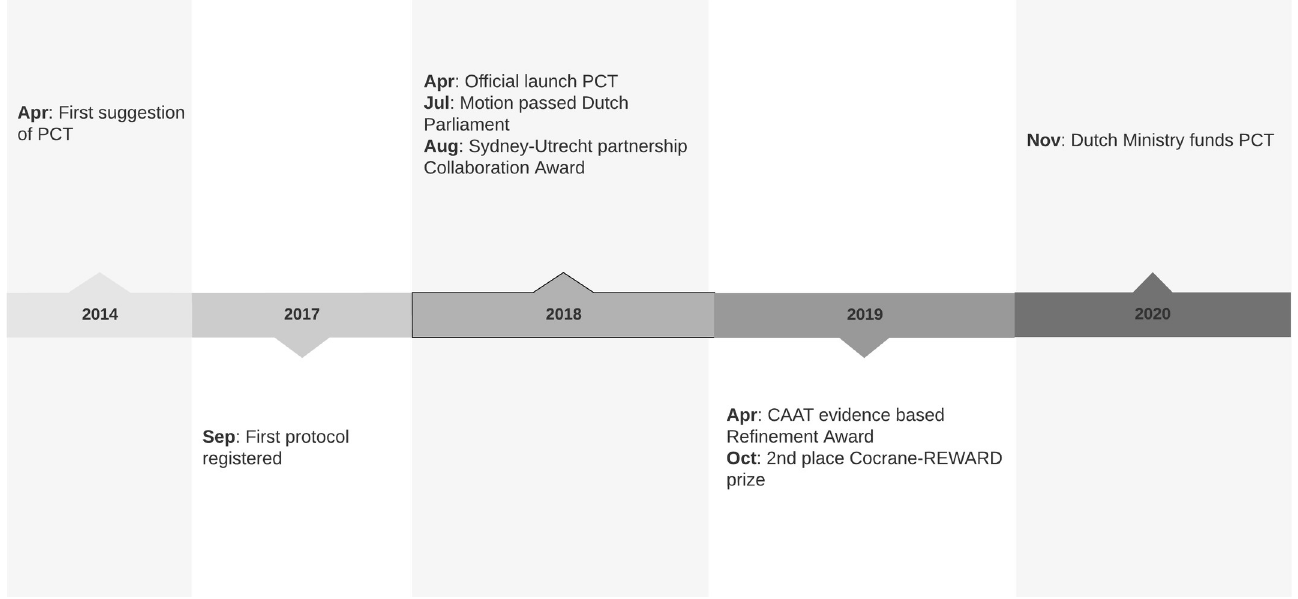
Fig 1. Timeline of the development of PCT. C AU : AnabbreviationlisthasbeencompiledforthoseusedthroughoutFig 1 : Pleaseverifythatallentriesarecorrect : AT, Center for Alternatives to Animal Testing; PCT, preclinicaltrials.eu.